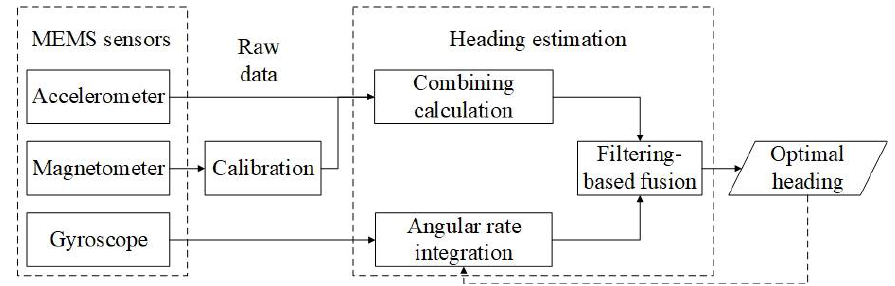
Figure 1. Architecture of the heading estimation approach.